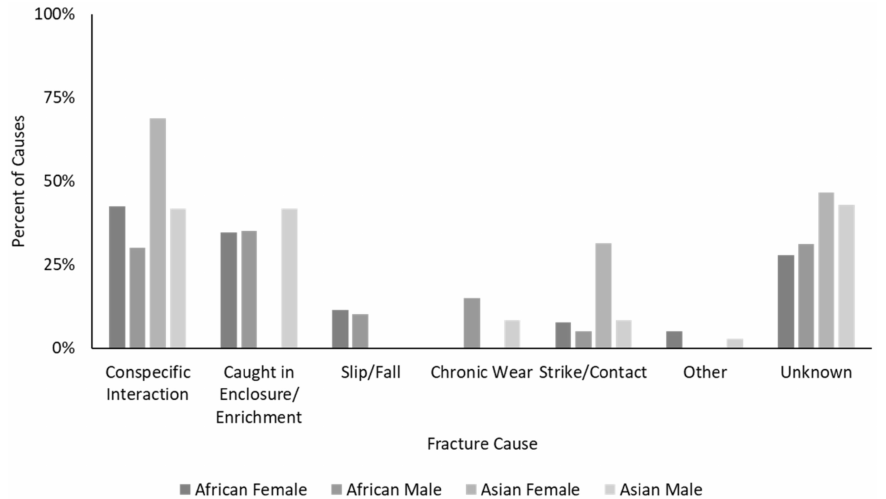
Figure 2. Percent of causes of tusk fractures by species/gender grouping. Unknown causes are calculated as a percent of all fractures. Known causes are calculated as a percent of all fractures with known